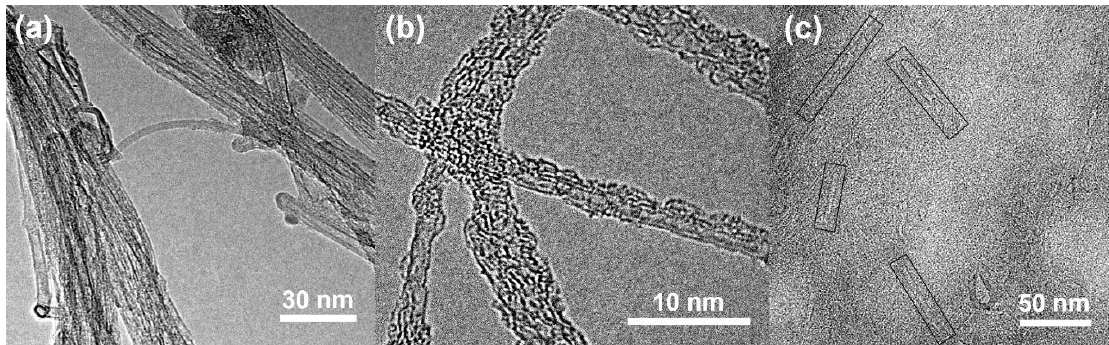
Figure 2. The HR-TEM images of ( a ) as-purchased SWNTs, and ( b , c ) functionalized c-SWNTs after sonication cutting.